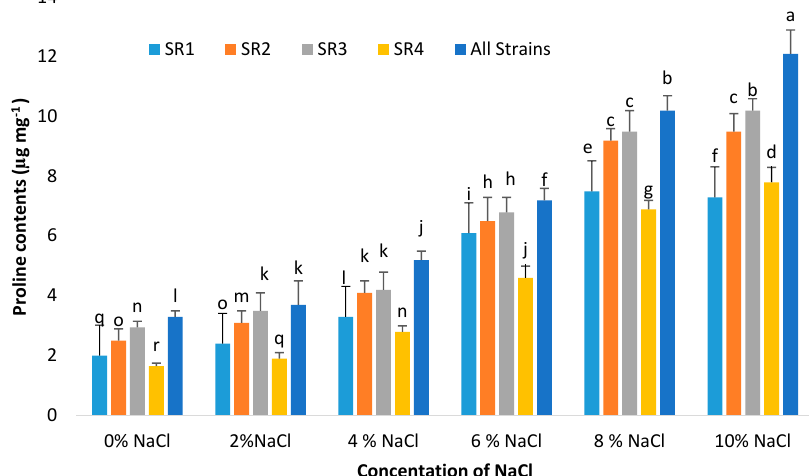
Figure 2. Production of proline by PGPR strains and their consortium in culture media supplemented with di ff erent concentrations of NaCl (2%, 4%, 6%, 8%, and 10%). The treatment details are the same as in Table 3. This data displays the means and standard deviation ( n = 3). Di ff erent letters show significant di ff erences between treatments ( p <